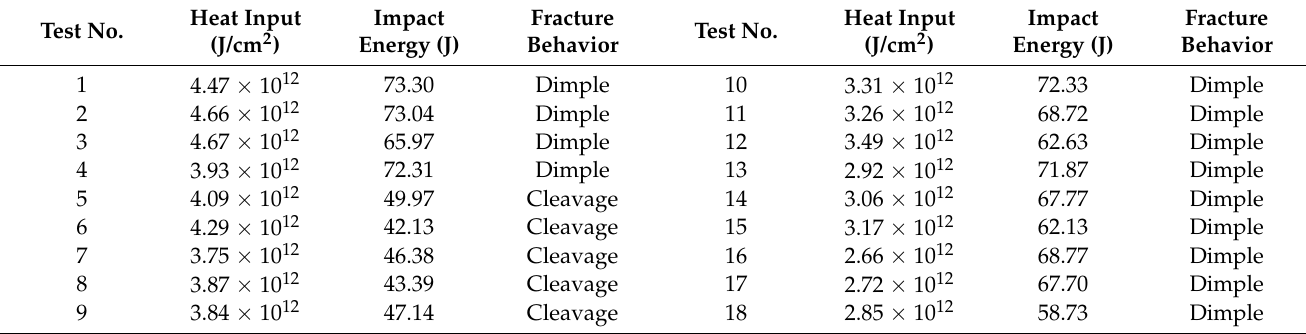
Table 9. Brittle fracture behavior data for discriminant analysis in flux core arc